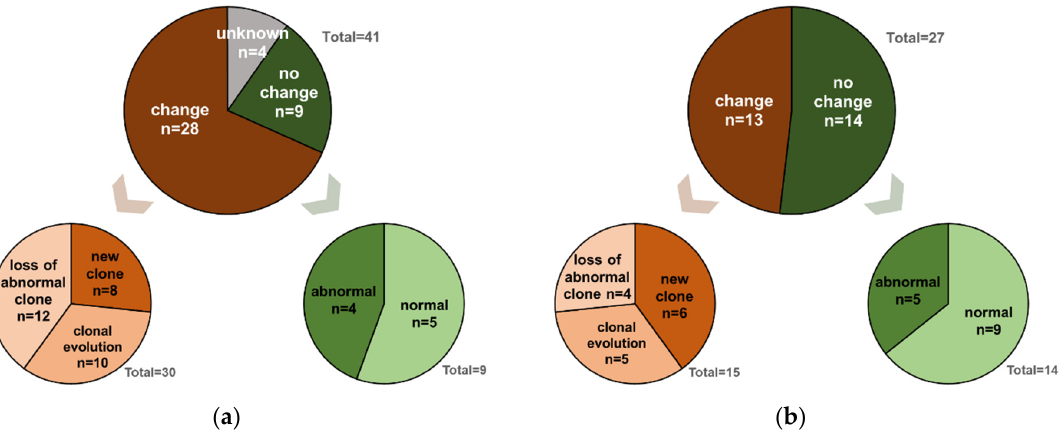
Figure 3. Comparative karyotype analyses prior to allo-SCT and at the time of early relapse ( a ) or late relapse ( b ): ( a ) relapse ≤ 12 months post allo-SCT , ( b ) relapse > 12 months post allo-SCT. Karyotype changes more frequently occurred in the subgroup of patients with early ( n = 28/37, 76%) than those with late ( n = 13/27, 48%) relapse ( p = 0.03). The proportion of patients showing a different karyotype in a relapse sample compared with a sample of prior-to allo-SCT was depicted in dark brown (= change), while the proportion of patients whose karyotype did not change at relapse compared with a pretransplant sample was illustrated in dark green (= no change). Karyotype changes